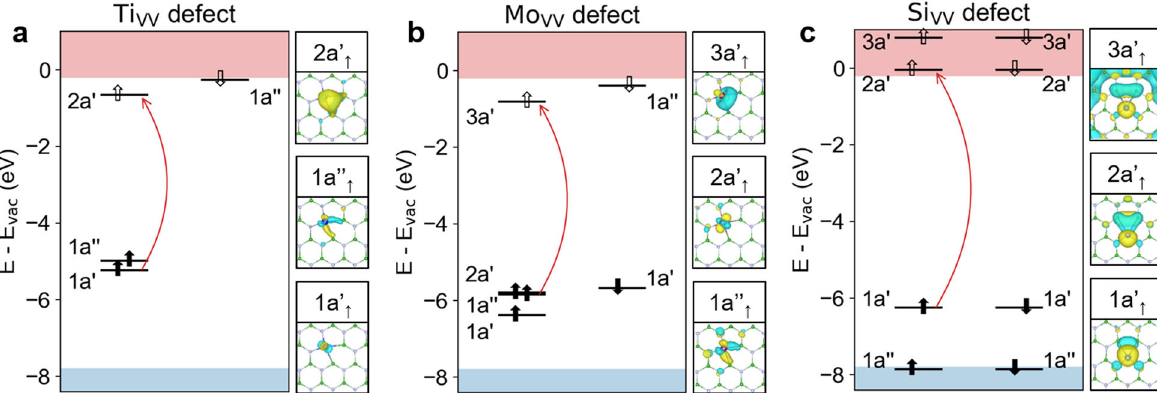
Fig. 2 Single-particle levels and wavefunctions. Single-particle defect levels (horizontal black lines) of the a Ti VV , b Mo VV , and c Si VV defects in h -BN, calculated at G 0 W 0 with PBE0( α ) starting wavefunctions. The blue/red area corresponds to the valence/conduction band of h -BN. States are labeled by their ordering and representation within the C S group with up/down arrows indicating spin and fi lled/un fi lled arrows indicating occupation. A red arrow is drawn to denote the intra-defect optical transition found in Fig. 3. Defect wavefunctions at PBE0( α ) are shown with an isosurface value of 10% of the maximum. The blue and yellow color denotes different signs of wavefunctions.